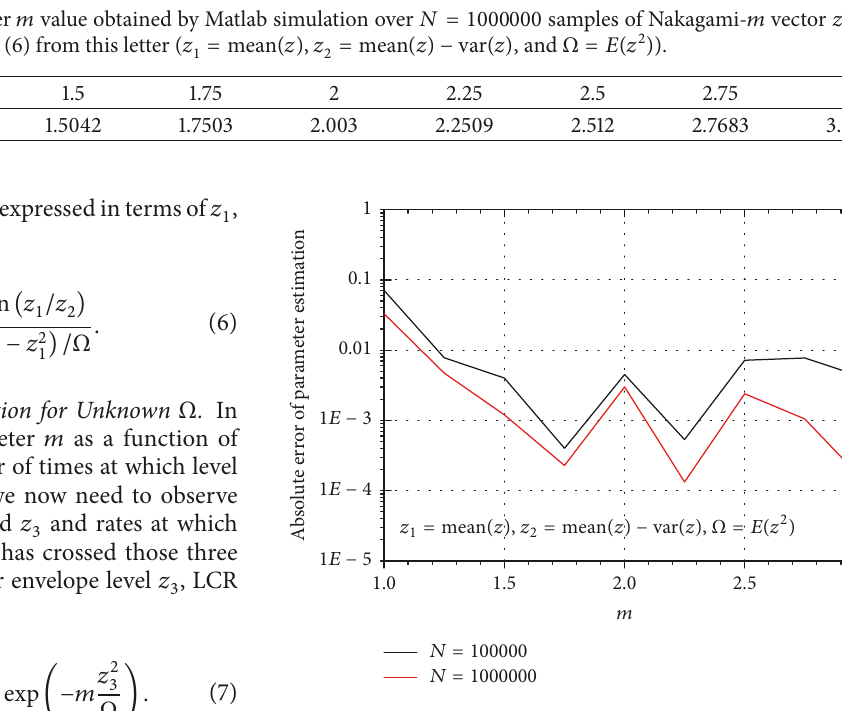
Figure 1: Absolute error of parameter